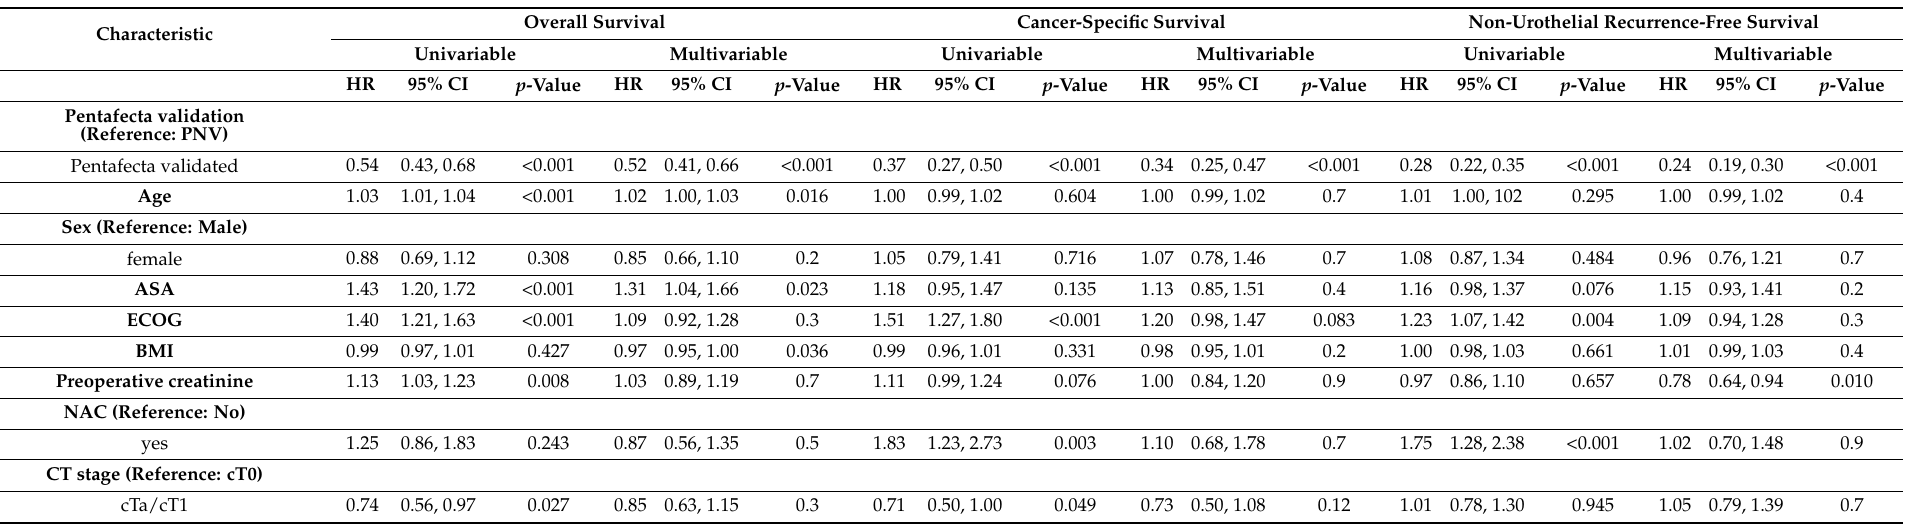
Table 4. Uni- and multivariable Cox regression analyses assessing the association of a validation of the pentafecta with non-urothelial recurrence-free, cancer-specific, and overall survival. PNV = Pentafecta not validated; ASA = American Society of Anesthesiologists Score; ECOG = Eastern Cooperative Oncology Group Status; BMI = Body mass index; NAC = neoadjuvant chemotherapy; LND = lymph node